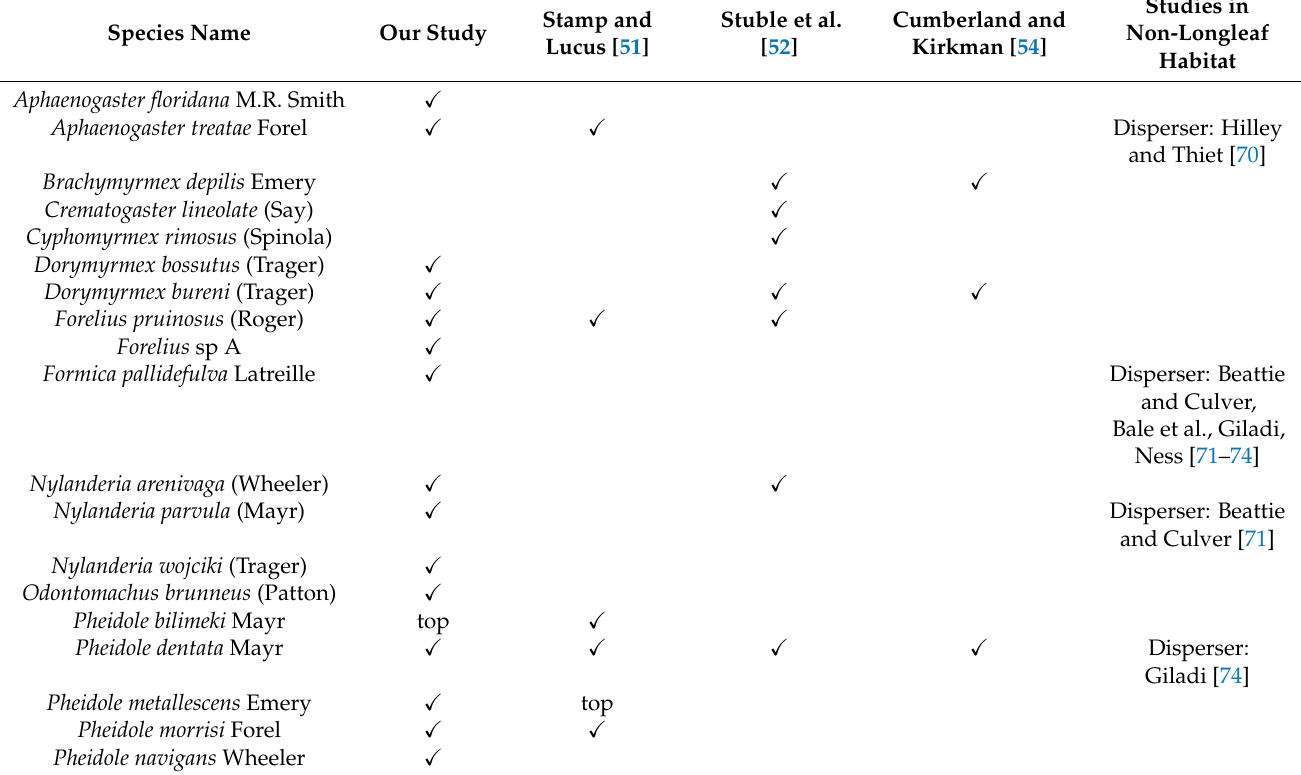
Table 2. Seed-removing ant species present in LLP ecosystems identified in this and other